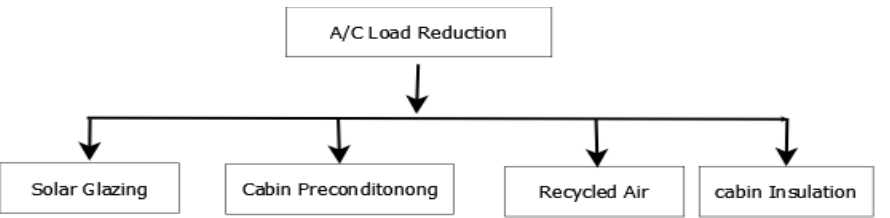
Figure 10. Various methods of reducing air conditioner load.